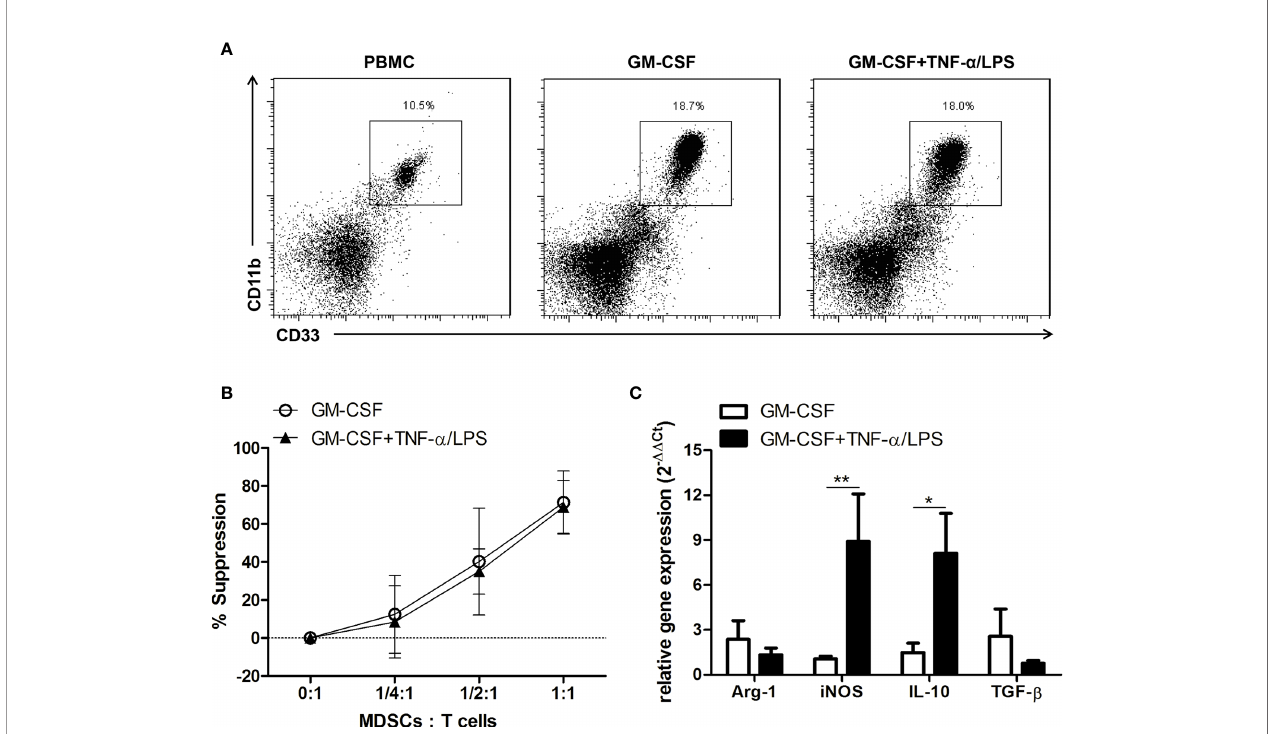
FIGURE 8 | TNF- a and lipopolysaccharide (LPS) increase the mRNA expression of iNOS and IL-10 in in vitro -generated human myeloid-derived suppressor cells (MDSCs). (A) Human CD11b + CD33 + MDSCs generated from PBMCs. (B) The suppressive abilities of human MDSCs. (C) mRNA expression of human MDSCs. *P < 0.05, **P < 0.01, n=5 for each group, Mann-Whitney test. Data were expressed as mean ±